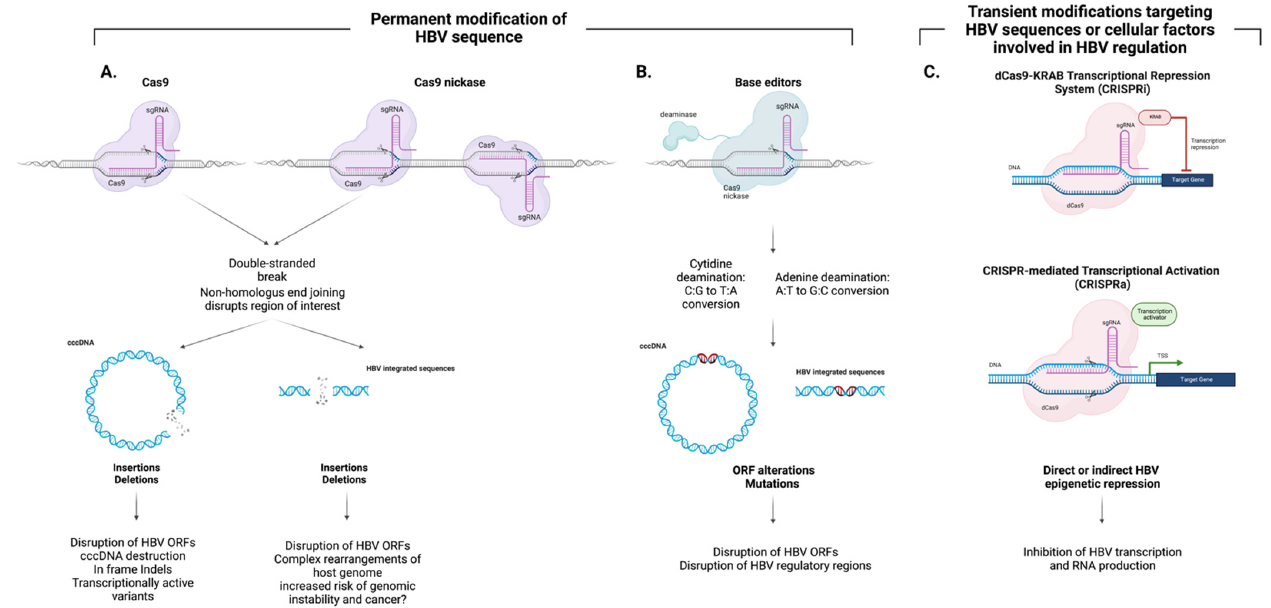
Figure 2. Cas9-based approaches for HBV genome editing. ( A ) Standard Cas9 and Cas9-nickase act through generating a double-stranded break (DSB), which may lead to large deletions and genomic rearrangements, especially in cases where several locations in the genome are targeted. In addition to an episomal cccDNA, chronic hepatitis B patients typically have multiple copies of HBV DNA integrated into their genome, so the possibility of chromosomal translocations is significantly increased. ( B ) Newer editing systems, such as base editing, result in permanent modification of the genome without generating DSBs. ( C ) Alternative approaches rely on the fusion of catalytically inactive Cas9 (dCas9) to transcriptional activators or repressors. These strategies aim at transiently affecting HBV RNA production and thus replication by modifying the HBV epigenome either directly or indirectly by targeting HBV regulators. Image created with